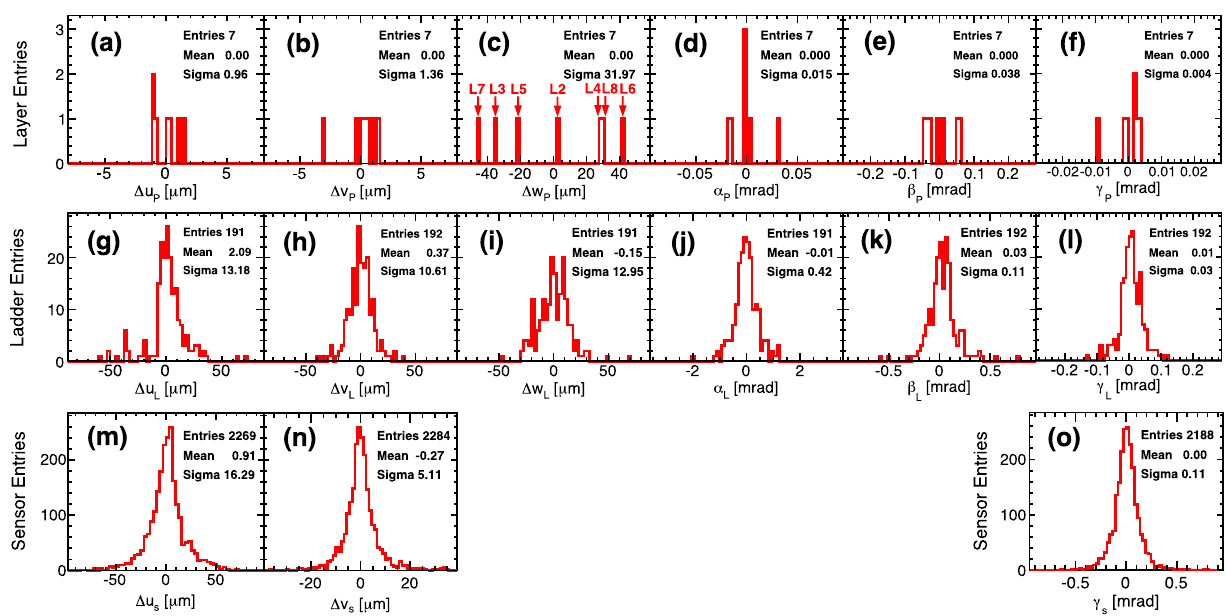
Fig. 25 The distributions of the alignment parameters of layers (top row, a – f ), ladders (middle row, g – l ), and sensors (bottom row, m-n-o ) obtained from the static alignment of all the tracker modules in space. The layer alignment parameters of L1 and L9 are not included in the plots ( a – f ) as they are dynamically aligned using the position of the inner tracker for the